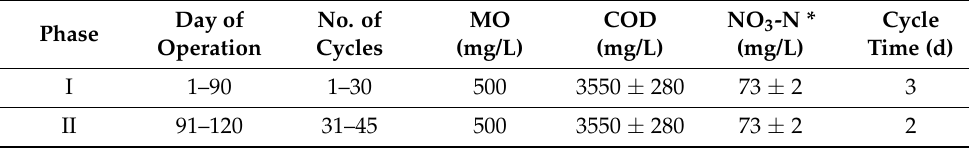
Table 1. Operational parameters of enrichment of biomass in